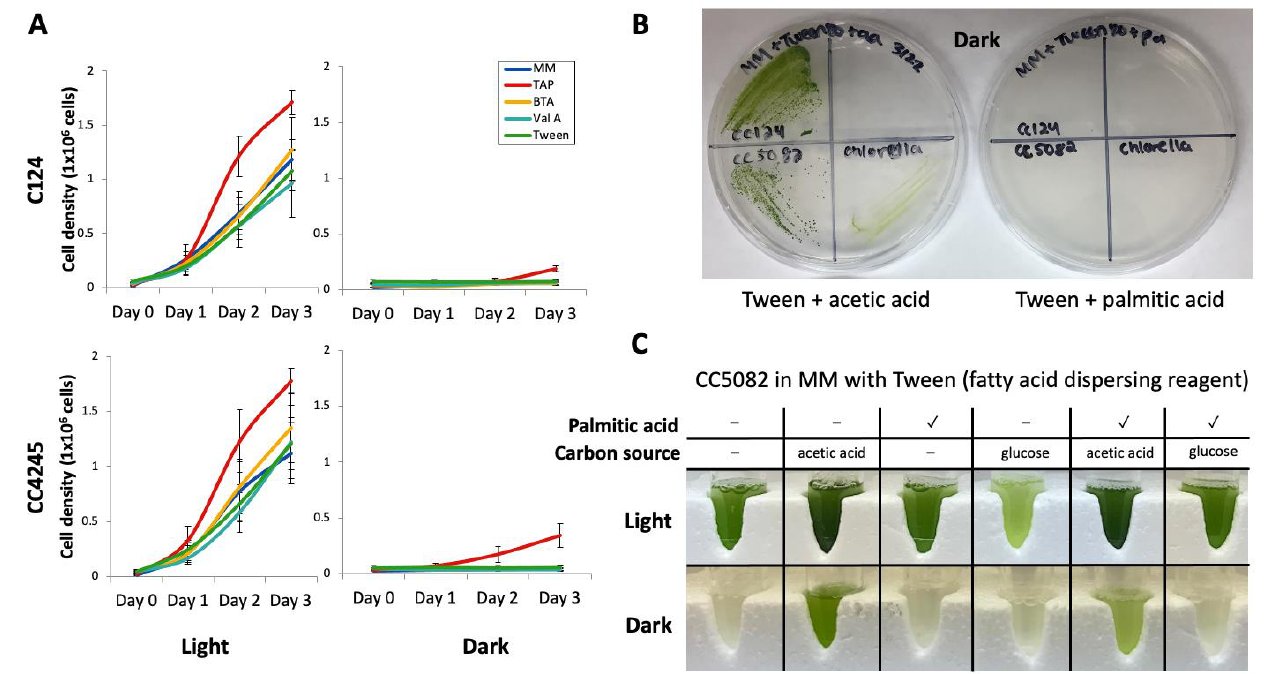
Figure 1. C. reinhardtii is not able to grow on exogenous fatty acids. ( A ) C. reinhardtii culture cell density after 3 d following transfer from TAP medium to minimal medium (MM), TAP, or MM with the addition of butyric acid (C4, BTA) in Tween 80 (FA dispersing agent, Tween), valeric acid (C5, Val A) in Tween 80, or Tween 80 alone. About 5 × 10 6 cells of strain CC124 or CC4425 were transferred to each new medium for each experiment. The graph shows averages ± standard error mean of three independent experiments. ( B ) Growth of C. reinhardtii and C. vulgaris cultured on agar plates without light. C. reinhardtii CC124, CC5082, and C. vulgaris (UTEX#395) were cultured for 4 d in TAP, then streaked on agar plates containing either acetic acid (C2 FA, left) or palmitic acid (C16 FA, right) and placed in the dark for 20 d. Tween is a dispersant for palmitic acid but did not affect growth with the acetic acid present. Growth was not observed when C16 FA was used as a sole carbon source in the dark (right Petri plate). ( C ) Growth of Chlamydomonas CC5082 cultured with different carbon sources. CC5082 was cultured for 14 days in liquid MM that contained Tween and other carbon sources, such as acetic acid, palmitic acid, and glucose. The cells were cultured with or without light. Notice that the cells proliferate in the dark only when acetic acid is in the medium.